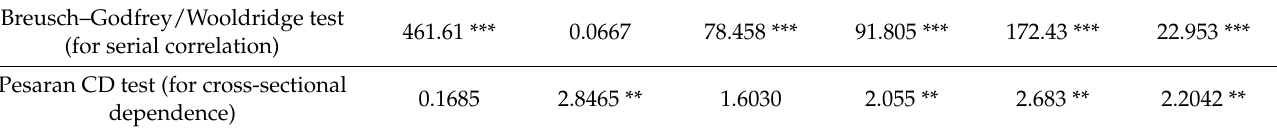
Table 6. Robustness checks for the two-way panel models with fixed effects estimator and standard errors. Breusch–Godfrey/Wooldridge test